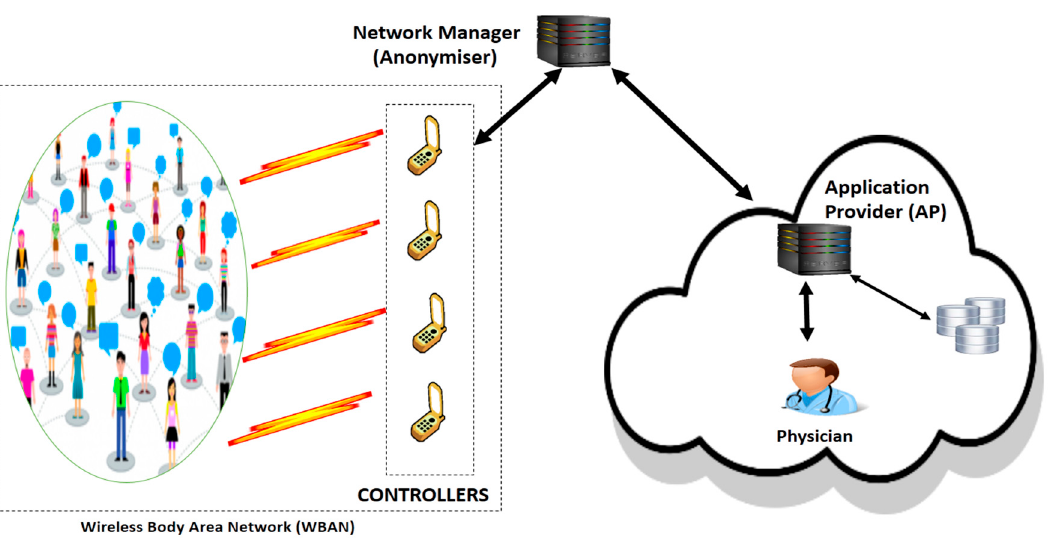
Figure 1. Proposed Figure 1. Proposed scenario.